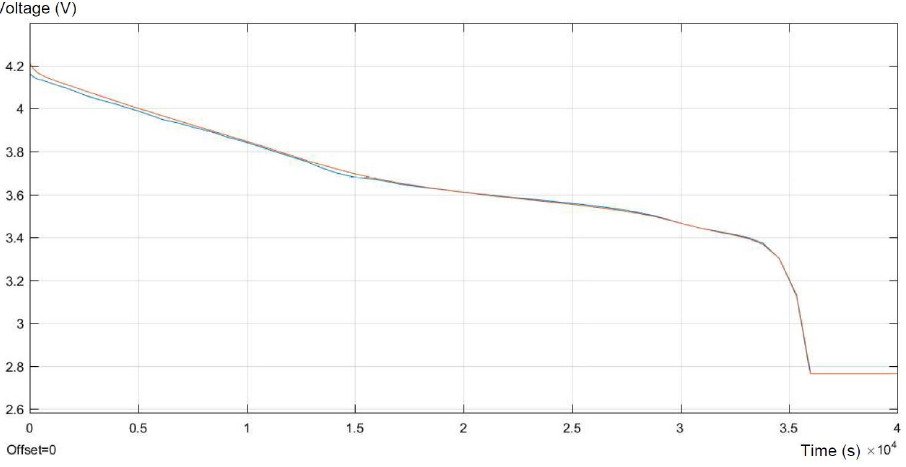
Figure 10. Comparison between the response of the model and experimental results from the discharge process performed with 0.1 C. The blue curve is the real, measured discharge process. The red curve presents the model response in the same